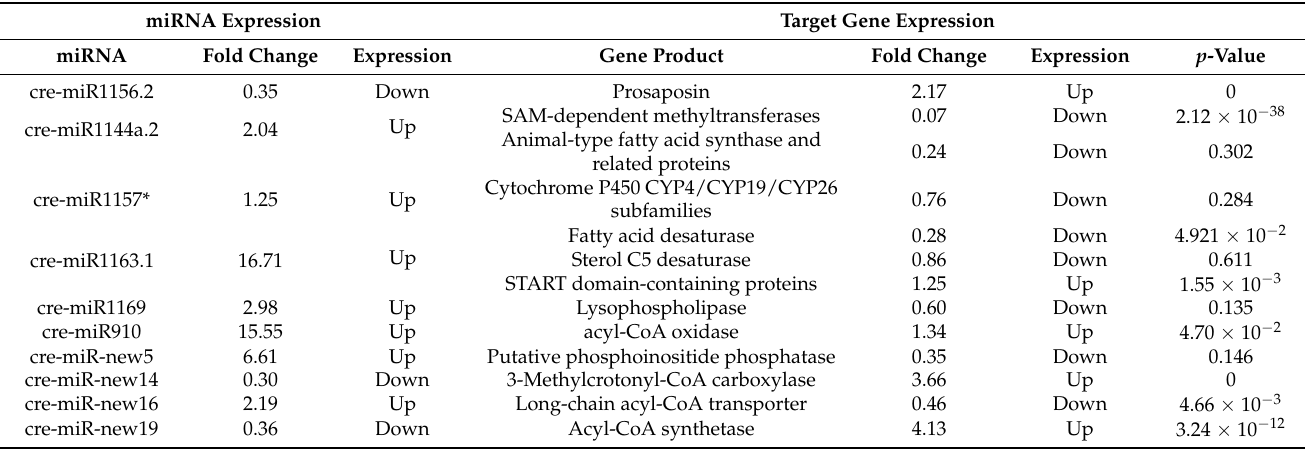
Table 3. Validation of the predicted genes involved in lipid transport and metabolism targeted by nitrogen deficiency-responsive miRNAs through high-throughput